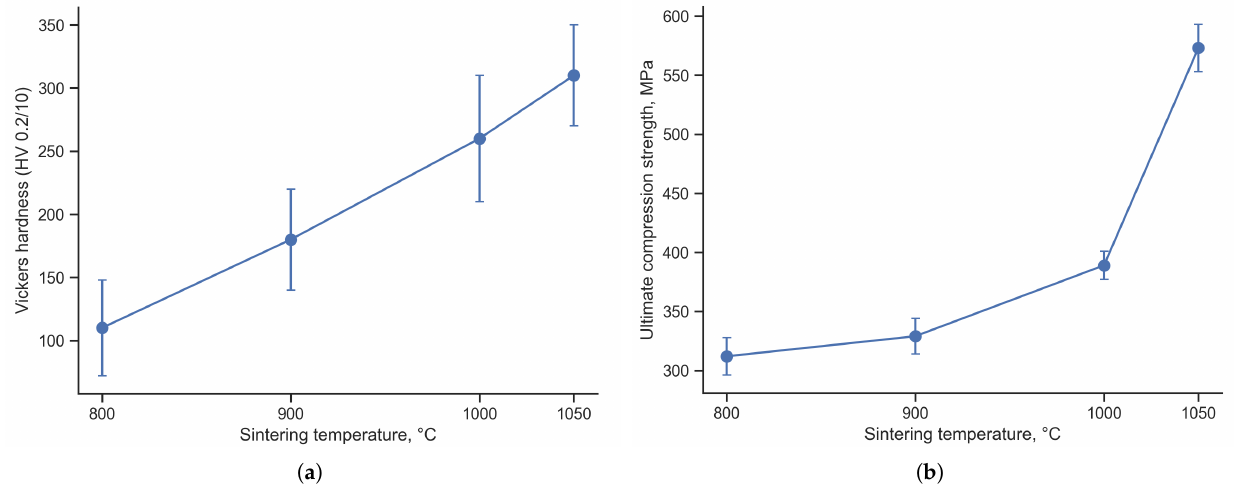
Figure 7. Vickers hardness ( a ) and ultimate compression strength ( b ) of Ti 3 AlC 2 :Cu samples after sintering at different